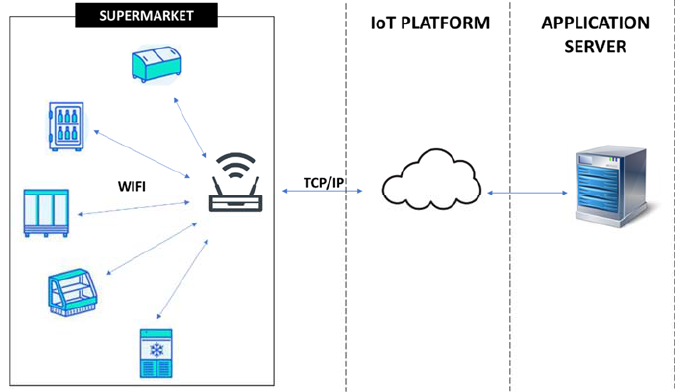
Figure 3. General solution based on Wi-Fi communication.